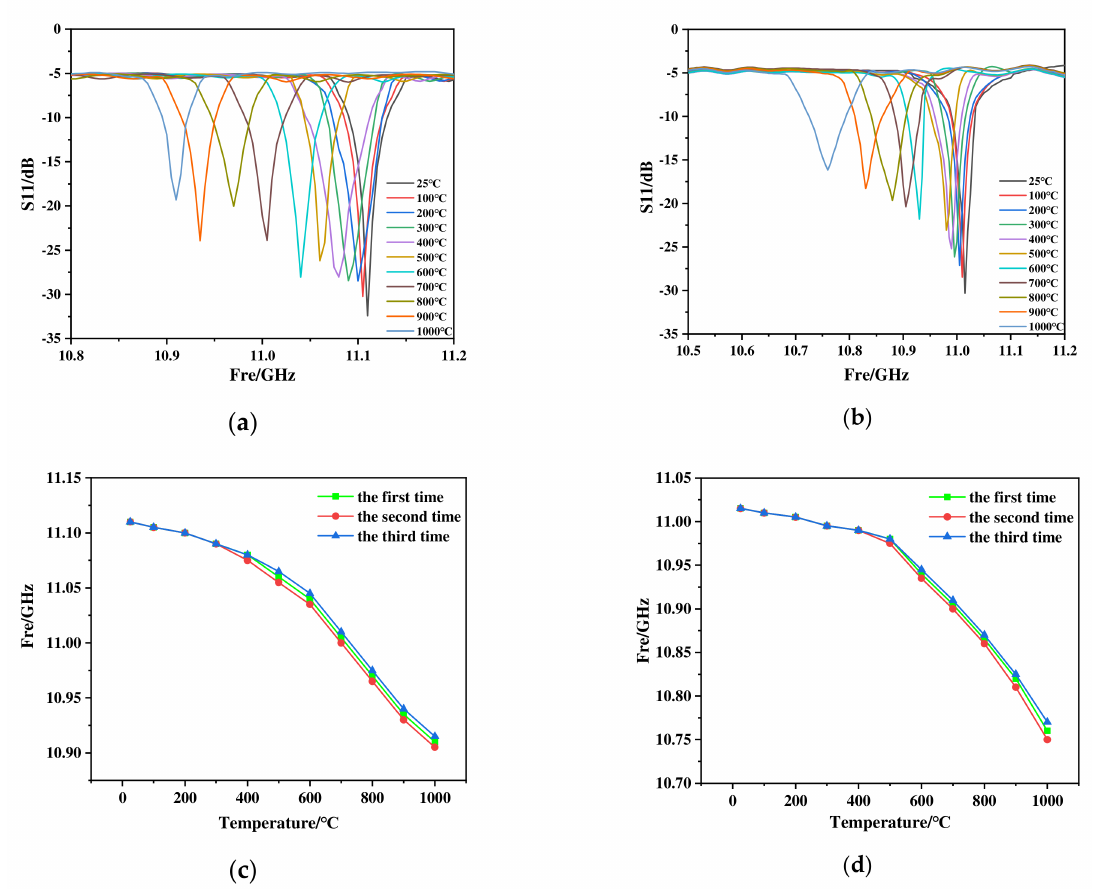
Figure 9. ( a , c ) The test results and repeated experiment results of Al 2 O 3 ceramic sensor, ( b , d ) the test results and repeated experimental results of SiC ceramic sensor.